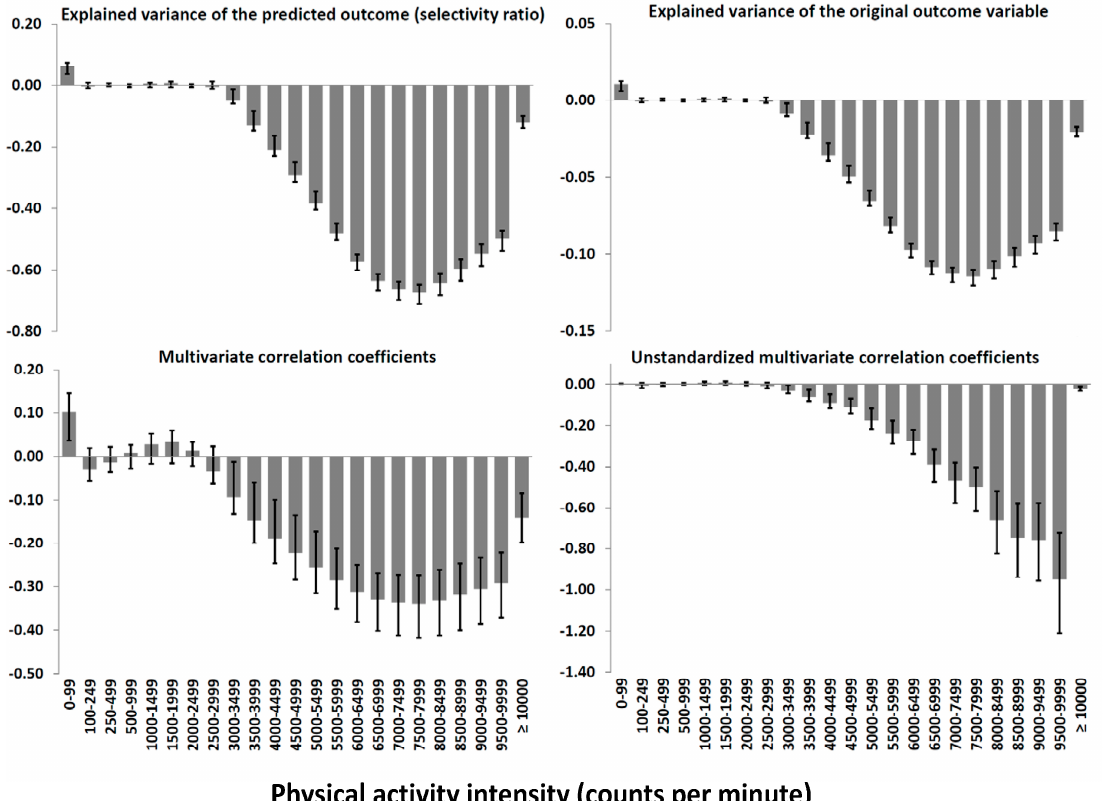
Figure 1. The multivariate association pattern between physical activity and cardiometabolic health reported using different statistics.